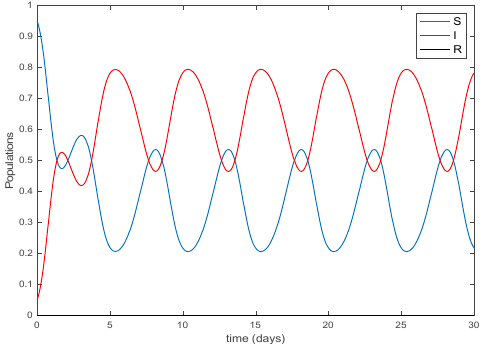
Vaccination. ( b ) Treatment.